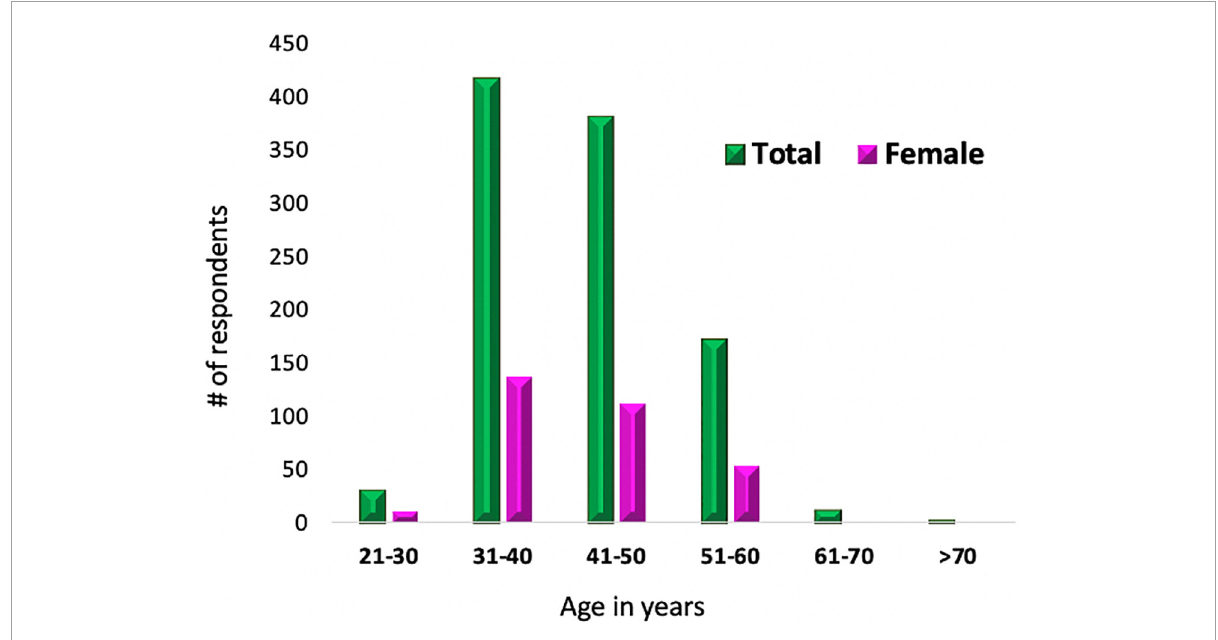
FIGURE3 Age distribution of surveyed CMR practitioners. This graph displays the age range distribution of the CMR surveyed practitioners with the breakdown of the percentage of women respondents.